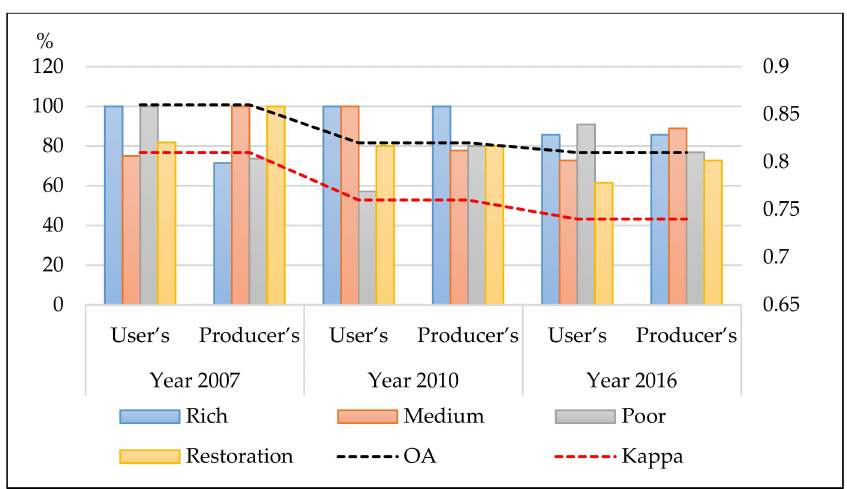
Figure 4. Forest types classification accuracies in user, producer (%), overall accuracy (OA), and kappa in the years 2007, 2010, and 2016.